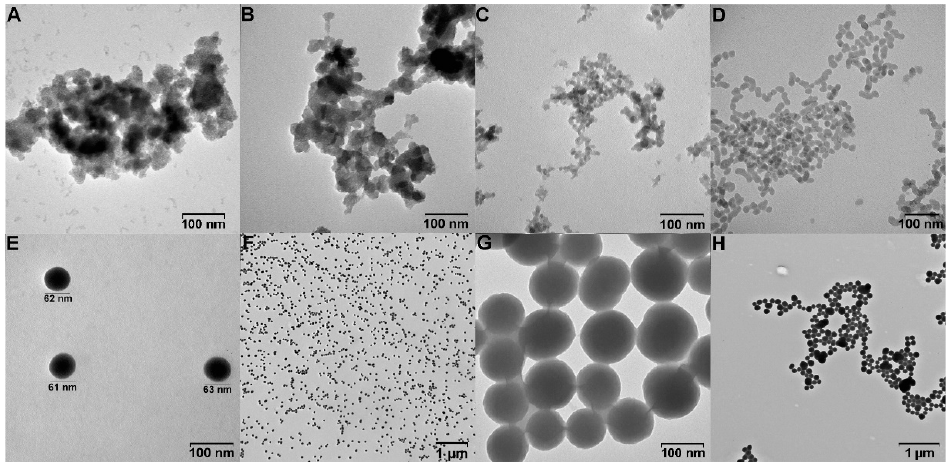
Figure 1. TEM images of SiNPs obtained by method 1 with CTAB ( A ) and HTAB ( B ); ( C ) SiNPs obtained by method 2; SiNPs obtained by method 3 with 0.040 M TEOS ( D ), 0.018 M TEOS ( E , F ), 0.200 M TEOS ( G , H ).